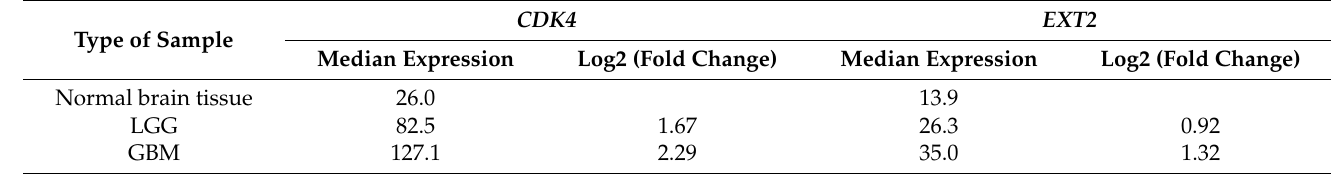
Figure 4. Differential CDK4 ( a ) and EXT2 ( b ) mRNA expression among normal brain tissue, low- grade glioma (LGG), and glioblastoma (GBM) in the OncoDB database. Grey boxes refer to normal brain tissue, green boxes refer to LGG, and red boxes refer to GBM. TPM: transcripts per kilobase of exon model per million mapped reads. **** p < 0.0001 (one way ANOVA test); p value of each comparison are reported. Table 5. Median expression of CDK4 and EXT2 mRNAs in normal brain tissue, low-grade glioma (LGG), and glioblastoma (GBM) in the OncoDB database, expressed in transcripts per kilobase of exon model per million mapped reads.